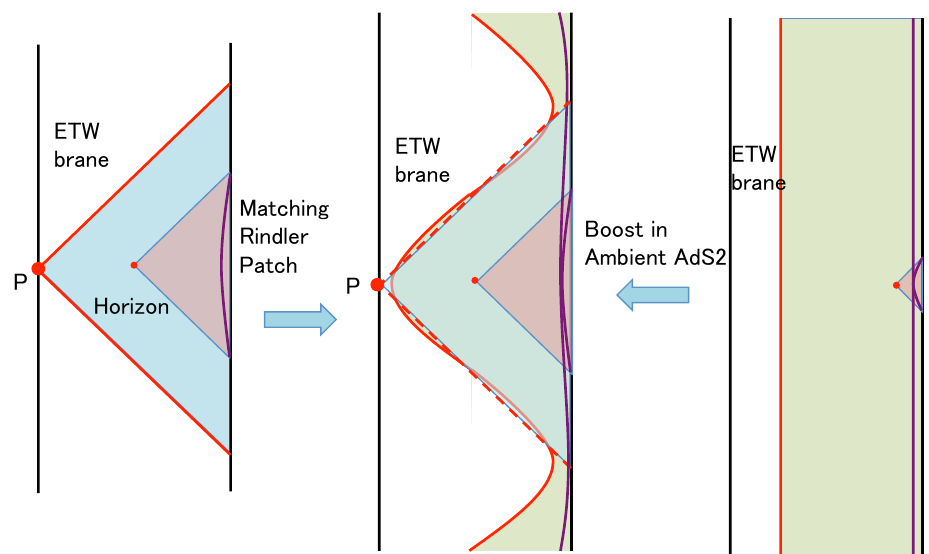
Figure 22 . A cartoon of the gravity con(cid:12)guration. The left is the bulk interpretation of the and the right is that of the G s ( (cid:22) ) . In the middle picture, we compare two geometries matching j i the Rindler patch of both geometries. From the Rindler observer, the EOW brane is falling. The Rindler observer feels the similar falling pattern for the EOW